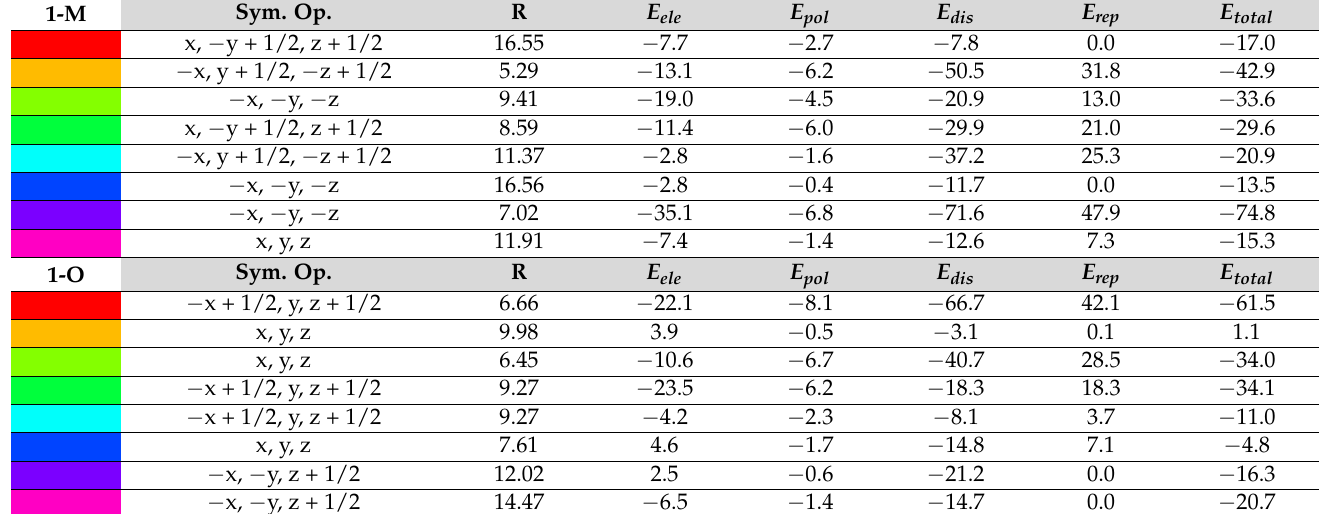
Table 2. Table listing calculated energies for the frameworks, color-coded by molecules in the images. 1-M Sym. Op.